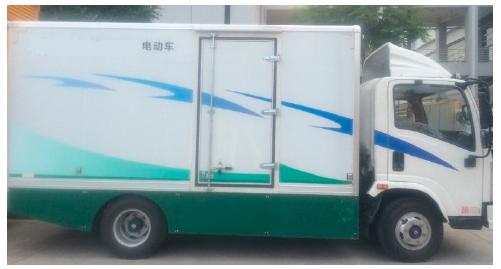
Figure 7. The tested electric logistic vehicle.